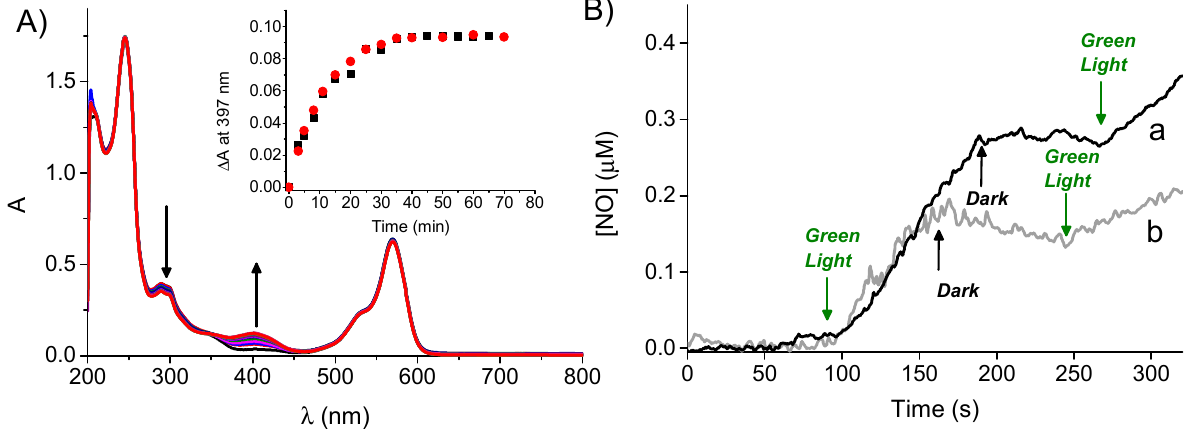
Figure 3. ( A ) Absorption spectral changes observed upon 532 nm light irradiation of a PBS (pH 7.4) solution of PolyCD (2 mg mL − 1 ) co-loaded with LVB (25 µM) and RD-NO (6 µM). The inset shows the absorbance changes at 397 nm of PolyCD (2 mg mL − 1 ) co-loaded with LVB (25 µM) and RD-NO (6 µM) ( λ ) and, for comparison, the same host in the absence of LVB ( ν ). ( B ) NO release profile observed for PolyCD (2 mg mL − 1 ) co-loaded with LVB (25 µM) and RD-NO (6 µM) (a) and, for comparison, the same host in the absence of LVB (b). T = 25 °C.